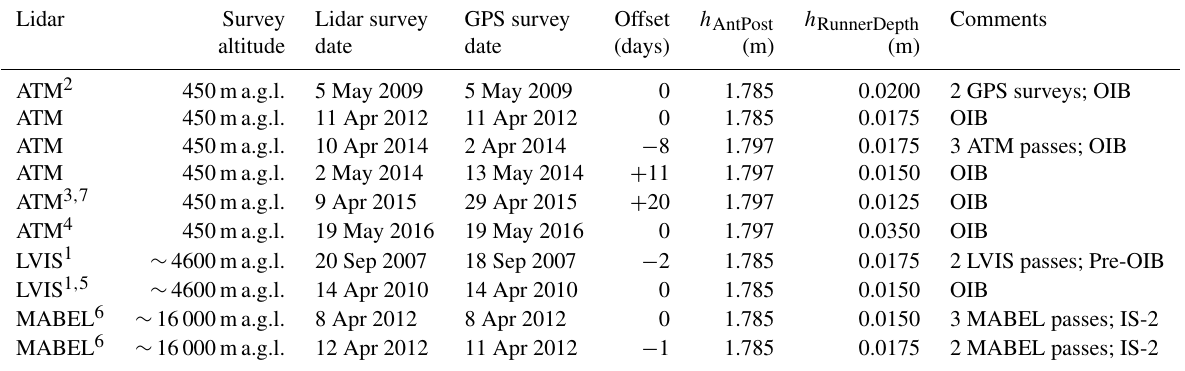
Table 1. Airborne laser altimetry and ground-based GPS survey dates and comments. Lidar Survey Lidar survey GPS survey